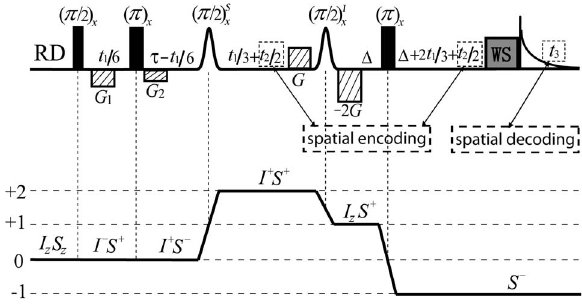
Figure 1. The DDF-SECSY sequence for high-resolution2D SECSY spectra in inhomogeneous fields via 3D acquisition. Full vertical bar stands for non-selective RF pulses, Gauss-shaped pulses are selective RF pulses, dash rectangles represent coherence selection gradients, ‘‘WS’’ is the spare module for solvent suppression. An optional ultrafast acquisition scheme is supplied by substituting the indirect detection period t 2 and direct detection period t 3 with spatially encoded and spatially decoded schemes, respectively, shown as the dotted-box modules. The coherence transfer pathway is given and the raising and lowering operators are applied to show the coherence states of I and S spins.